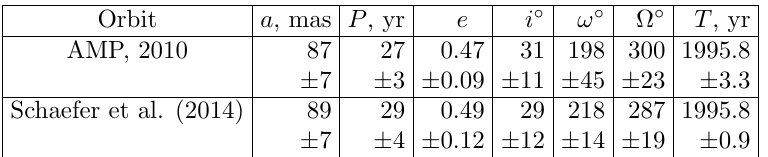
Fig. 1. Comparison of the orbits of T Tauri Sa-Sb: AMP (solid curve), Shaefer et al. (2014) (dashed curve). Observations: VLT/NACO ((cid:12)lled circles), VLT/SPHERE (open circles), other observations (crosses). Table 2. Orbital elements of the star T Tauri